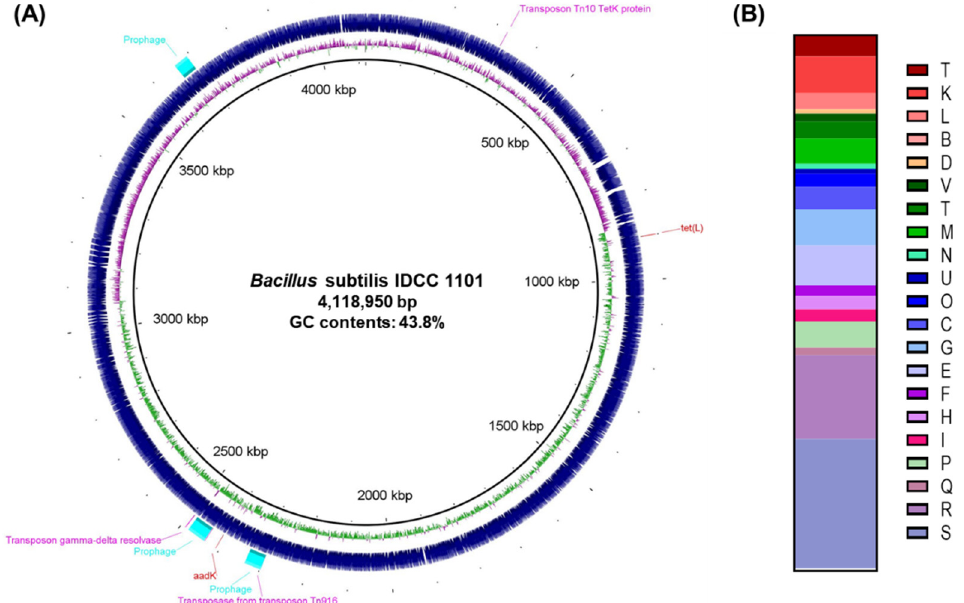
Figure 1. ( A ) Genome map and ( B ) annotated functional genes of B . subtilis IDCC1101. The ORFs were grouped based on the EggNOG standard into translation, ribosomal structure, and biogenesis (J); transcription (K); replication, recombination, and repair (L); chromatin structure and dynamics (B); cell cycle control, cell division, and chromosome partitioning (D); defense mechanisms (V); signal transduction mechanisms (T); cell wall, membrane, and envelope biogenesis (M); cell motility (N); intracellular trafficking, secretion, and vesicular transport (U); posttranslational modification, protein turnover, and chaperones (O); energy production and conversion (C); carbohydrate transport and metabolism (G); amino acid transport and metabolism (E); nucleotide transport and metabolism (F); coenzyme transport and metabolism (H); lipid transport and metabolism (I); inorganic ion transport and metabolism (P); secondary metabolite biosynthesis, transport, and catabolism (Q); general function prediction only (R); and function unknown (S).